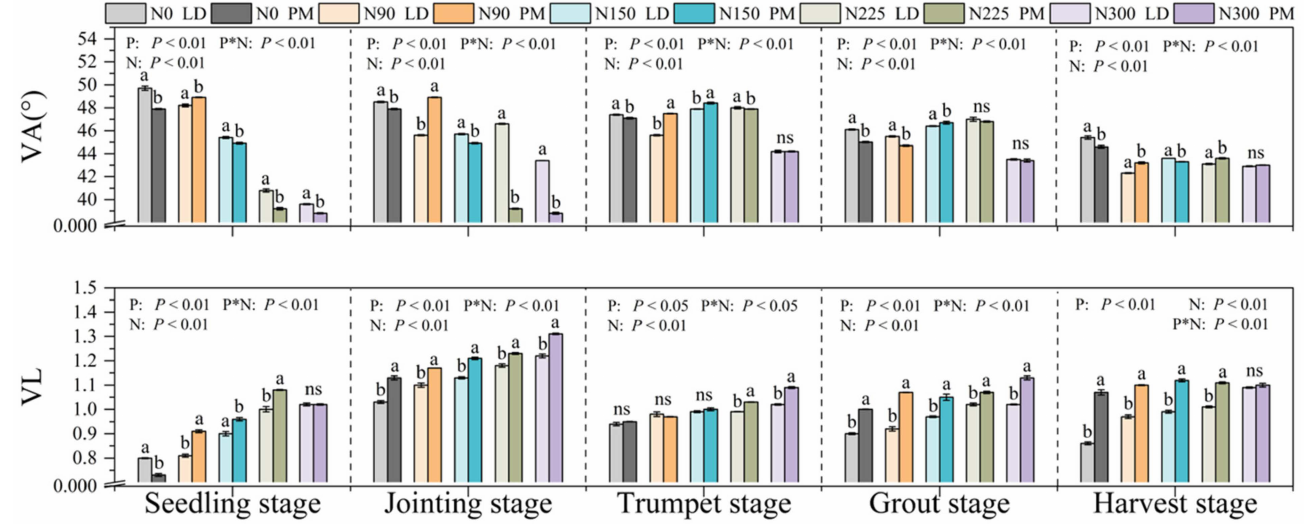
Figure 5. Vector analysis of soil enzymes under the different treatments. VA, vector angel ( ◦ ); VL, vector length; P, plastic film mulching; N, nitrogen levels; N*P, plastic film mulching * nitrogen levels; N0, nitrogen application level was 0 kg · hm − 2 ; N90, nitrogen application level was 90 kg · hm − 2 ; N150, nitrogen application level was 150 kg · hm − 2 ; N225, nitrogen application level was 225 kg · hm − 2 ; N300, nitrogen application level was 300 kg · hm − 2 . Different lowercase letters (a, b) indicate